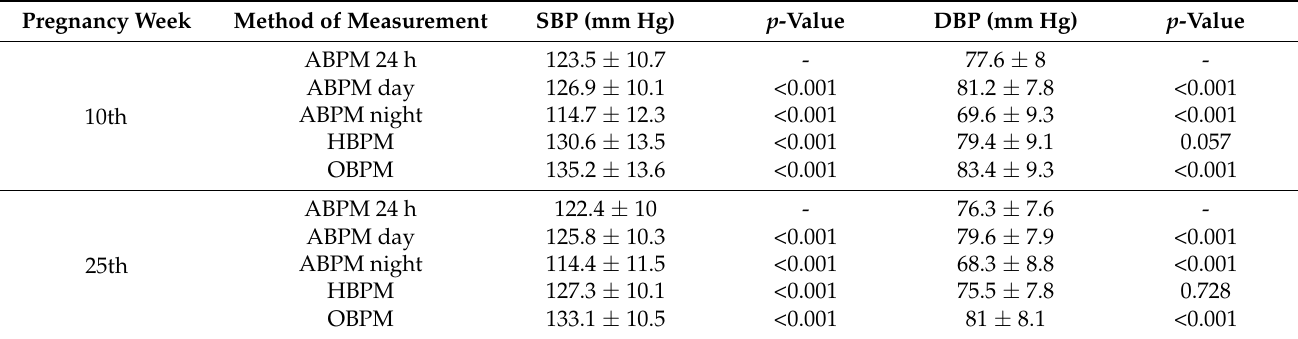
Table 2. Blood pressure values during pregnancy according to the period of the measurement (10th, 25th, 37th week) and method of blood pressure estimation. All comparisons of blood pressure values were made with ABPM 24 h systolic or diastolic blood pressure,